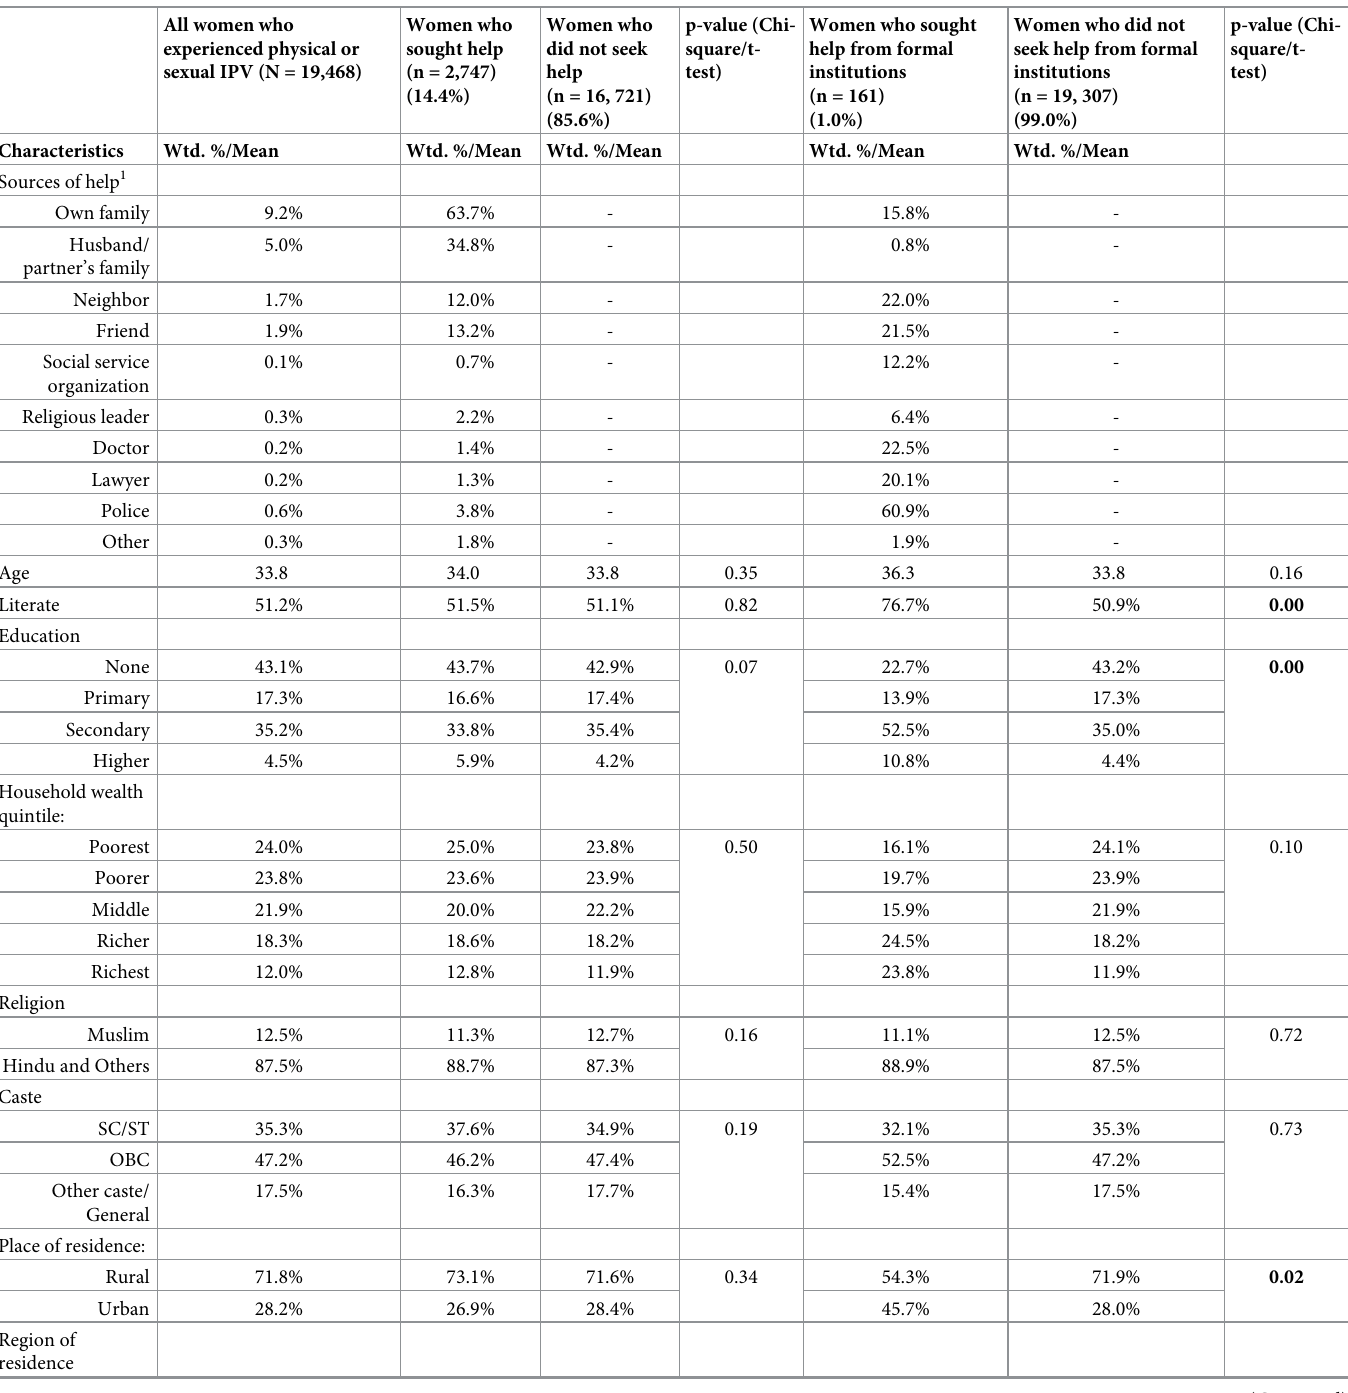
Table 1. Sample characteristics (N =